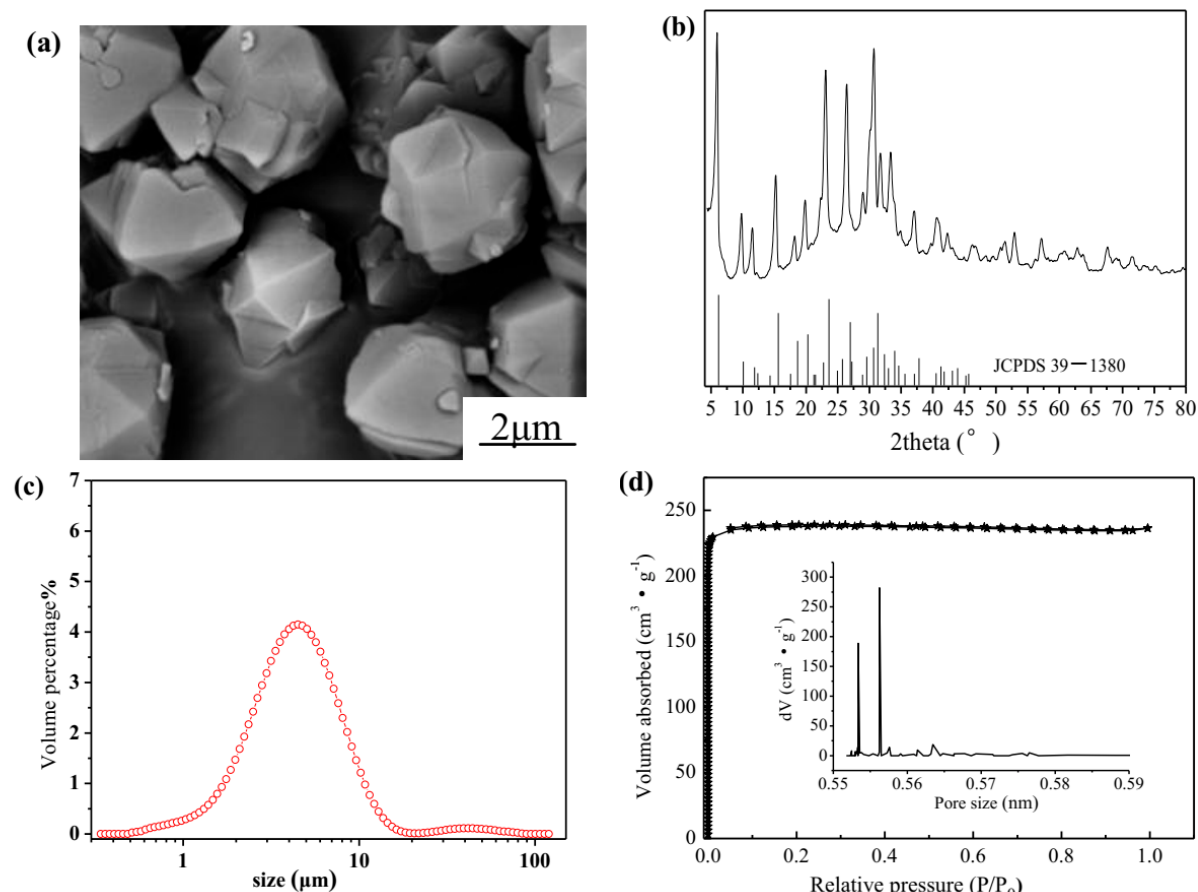
Figure 1. Characterization of NaX zeolite, SEM image ( a ), XRD pattern ( b ), particle size distribution ( c ), N 2 adsorption-desorption isotherms and Pore size distribution (inset) ( d ).